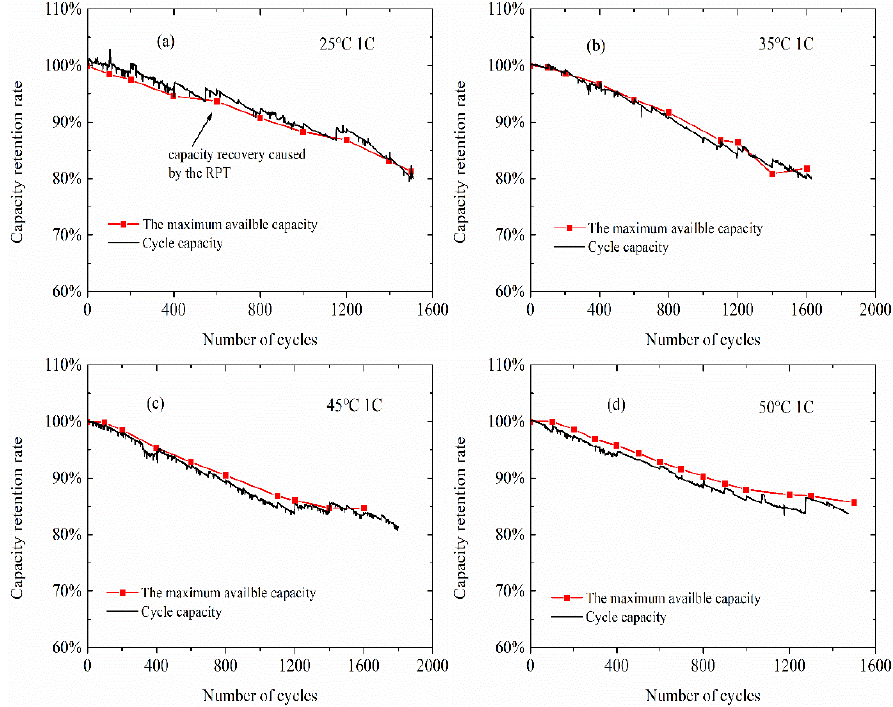
Figure 2. Comparison of the maximal available capacity and the cycle capacity of Battery I at different temperatures: ( a ) 25 ◦ C, ( b ) 35 ◦ C, ( c ) 45 ◦ C and ( d ) 50 ◦ C.